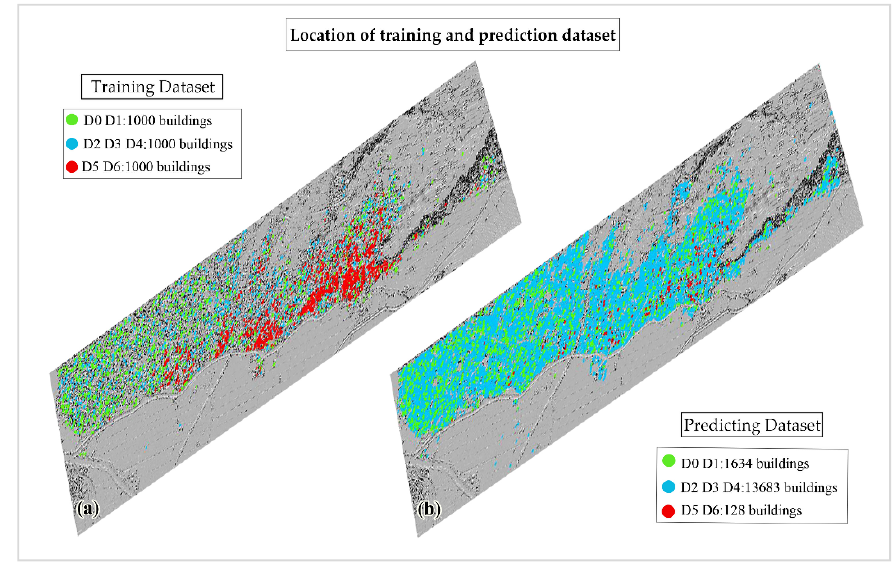
Figure 6. Location of training ( a ) and prediction ( b ) dataset of the study area. Green points (intact buildings), Blue points (low to medium damage) and Red points (Collapsed buildings) (3DR).